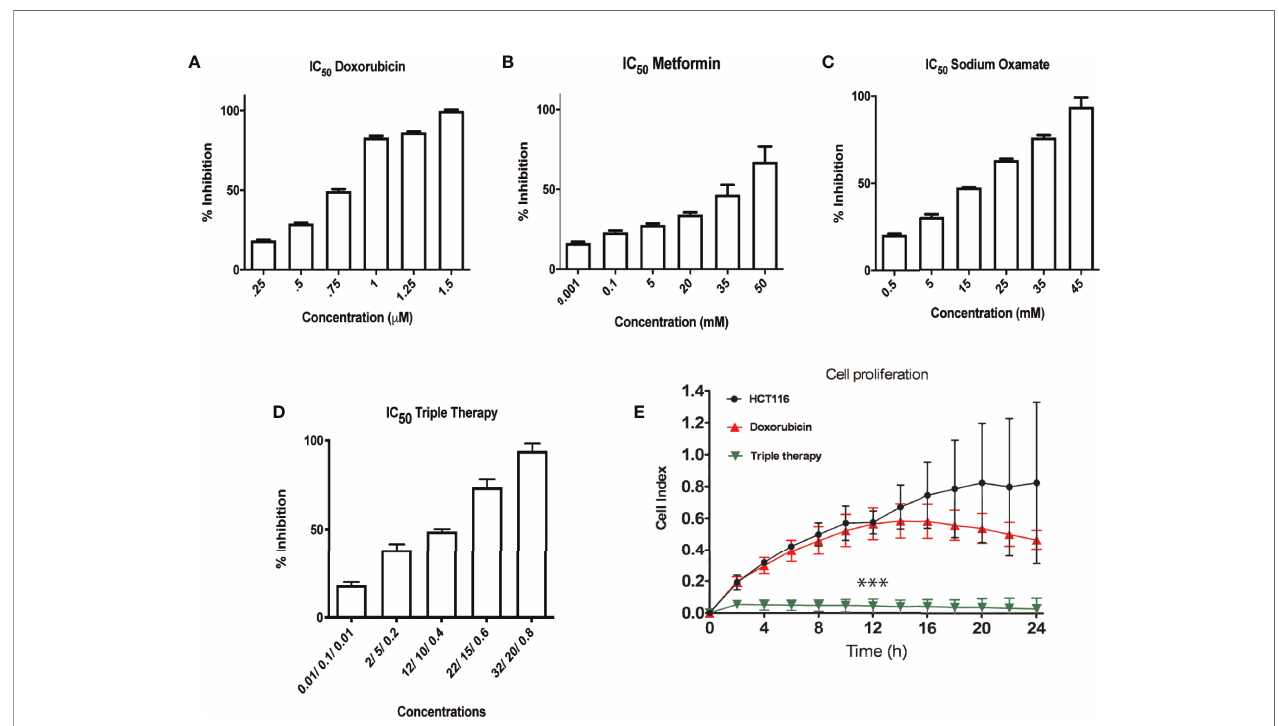
FIGURE 1 | Triple therapy inhibits proliferation in a HCT116 cell line. (A – C) Inhibitory Concentration 50 (IC50) of the drugs Doxorubicin, Metformin and Sodium Oxamate in the HCT116 cell line at 24 h of exposure to these drugs. (D) IC50 values of the drugs in combination. (E) Real Time cell proliferation of HCT116 under Dox and Tt treatment (***p <